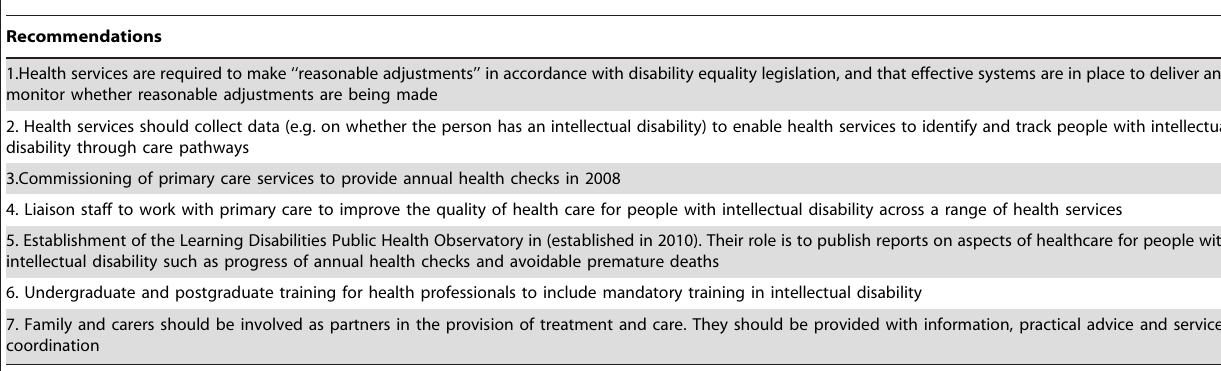
Table 1. Key recommendations to improve health care access for people with intellectual disability in England